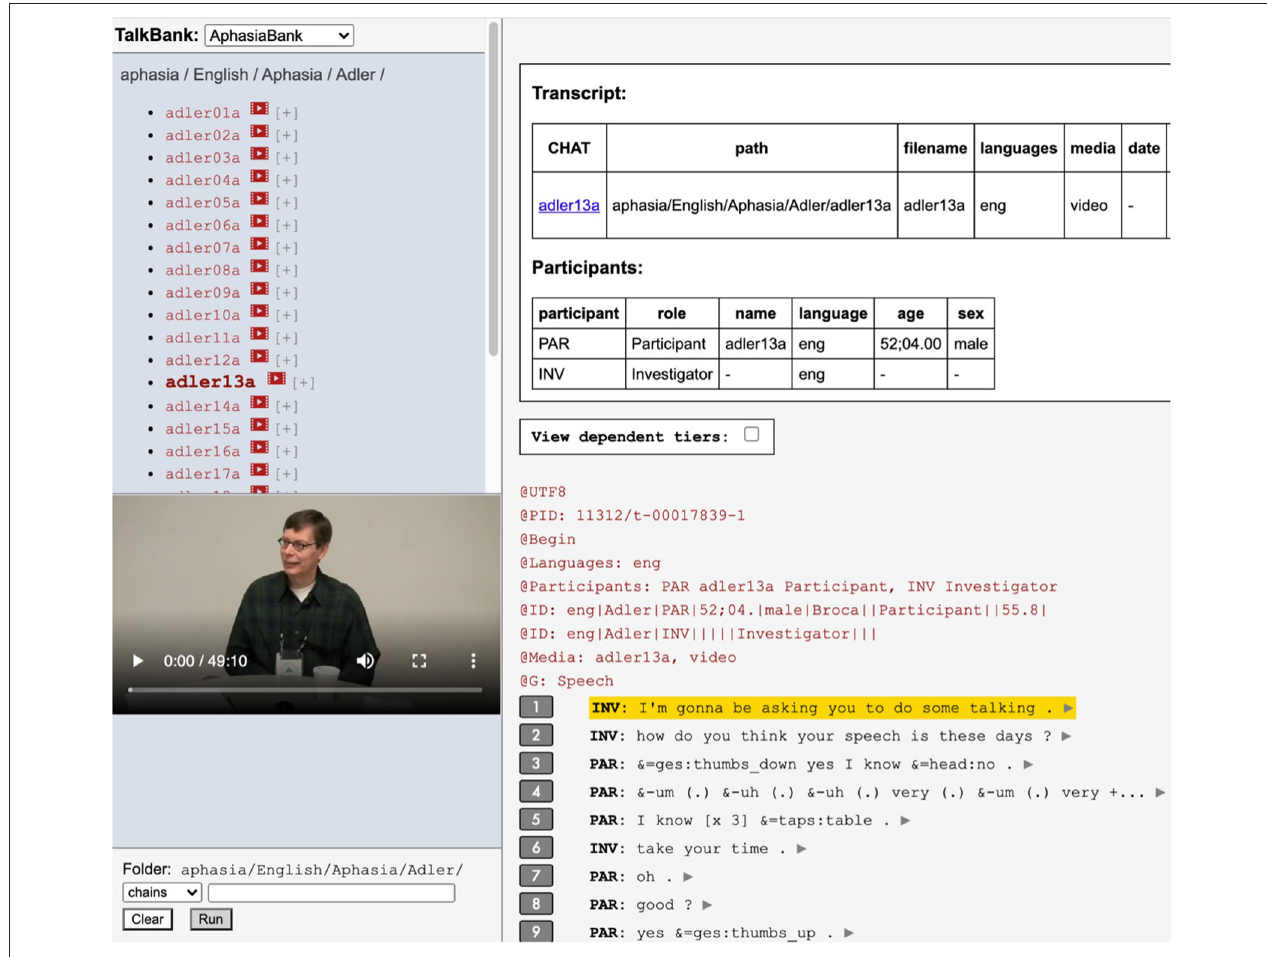
FIGURE 6 | TalkBank Browser